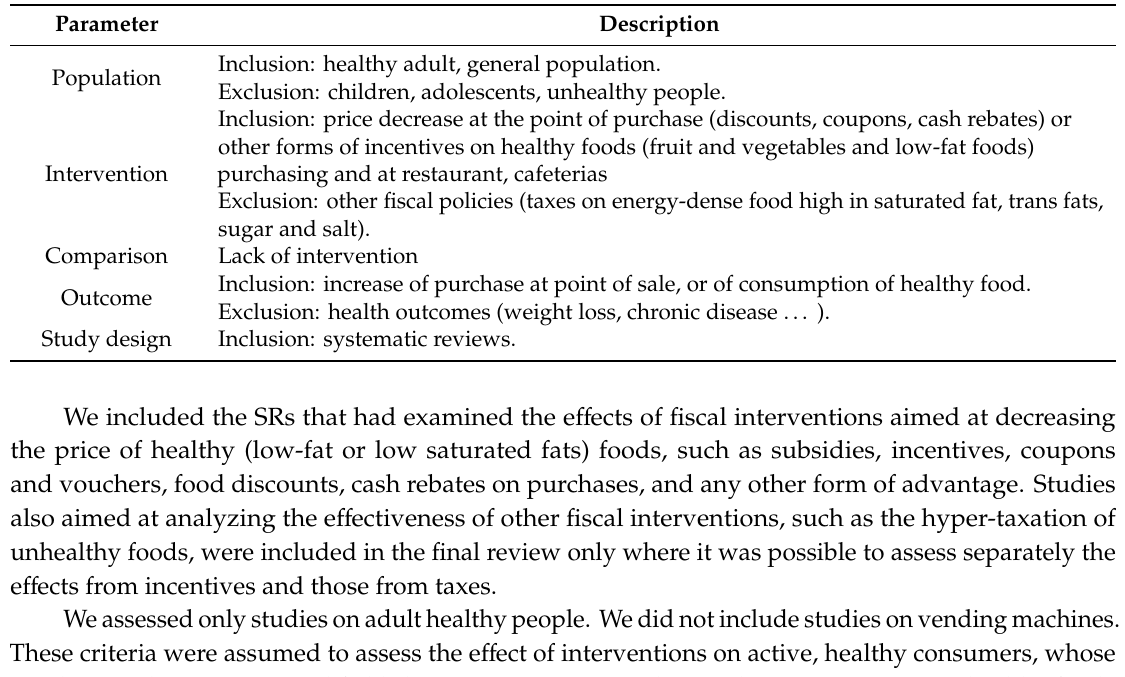
Table 1. Population, intervention, comparison, outcome, and type of study (PICOT) scheme to define inclusion criteria.